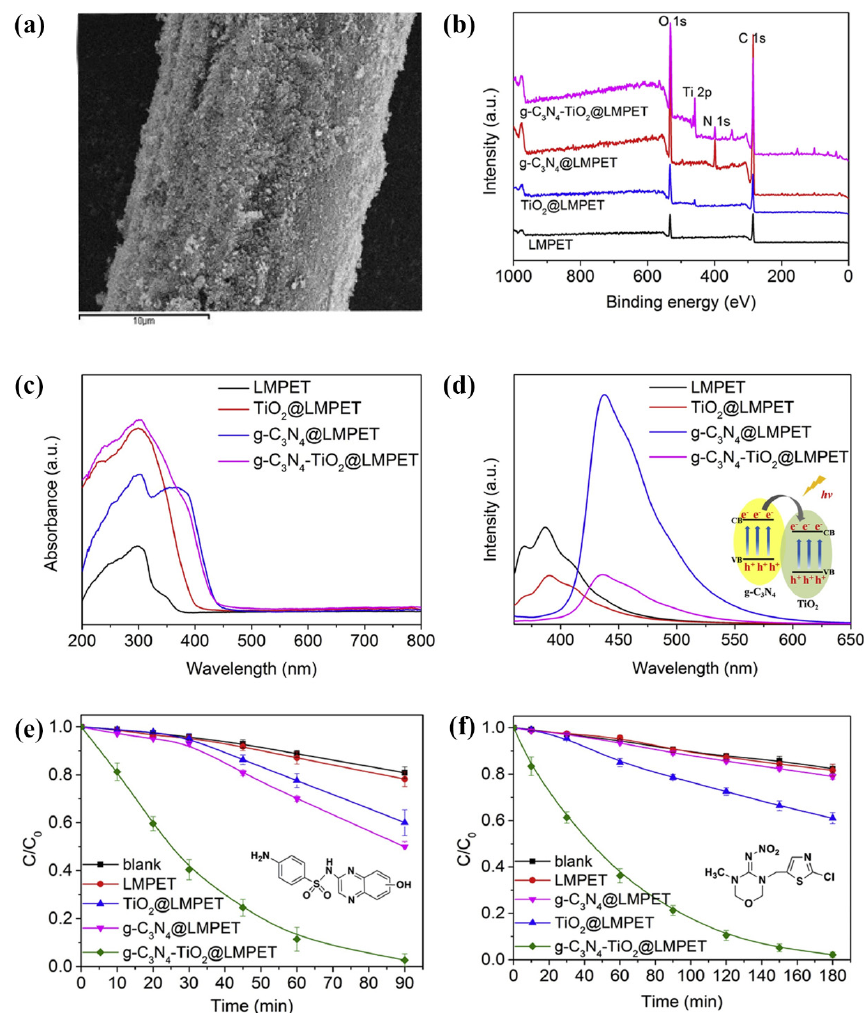
Figure 12. ( a ) Morphology of the g-C 3 N 4 -TiO 2 @LMPET surface. ( b ) XPS survey spectra. ( c ) UV–Vis diffuse reflectance absorption spectra of LMPET, TiO 2 @LMPET, g-C 3 N 4 @LMPET, and g-C 3 N 4 -TiO 2 @LMPET. ( d ) Photoluminescence (PL) spectra of LMPET, TiO 2 @LMPET, g-C 3 N 4 @LMPET, and g-C 3 N 4 -TiO 2 @LMPET. ( e , f ) Photocatalytic degradation of sulfa- quinoxaline (SQX) ( e ) and thiamethoxam ( f ) under different conditions exposed to solar irradiation (SQX = 2 × 10 − 5 mol/L, thiamethoxam = 2 × 10 − 5 mol/L, pH 7). Reprinted with permission from [53]. Copyright 2019, Elsevier.